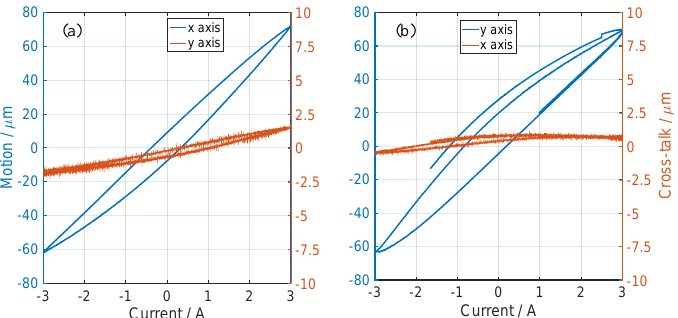
Figure 11. Motion and resulting cross-talk with maximum actuation along ( a ) the x -axis and ( b ) the y -axis.